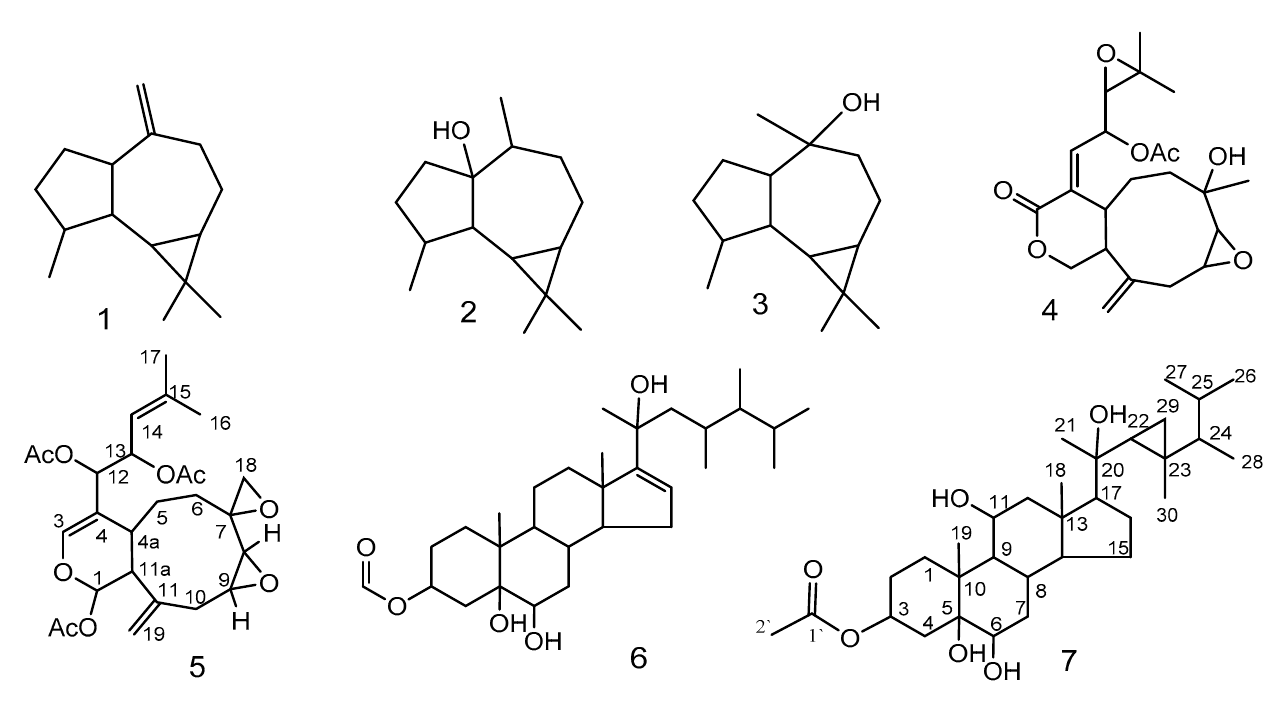
Figure 1. Compounds 1 – 7 isolated from Xenia umbellata. Table 2. 1 H and 13 C NMR spectral data of compound 7 a . Table 1. 1 H and 13 C NMR spectral data of compound 5 a